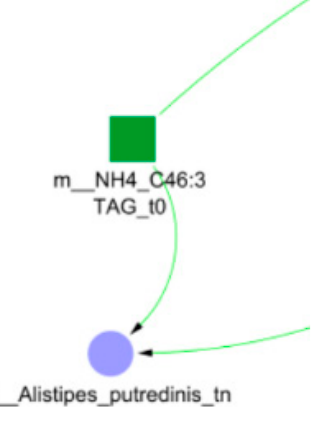
Figure 10. Identified connections between metabolite (green square) and taxa (purple circle) through the inspection of the dynamic Bayesian network model for UC.